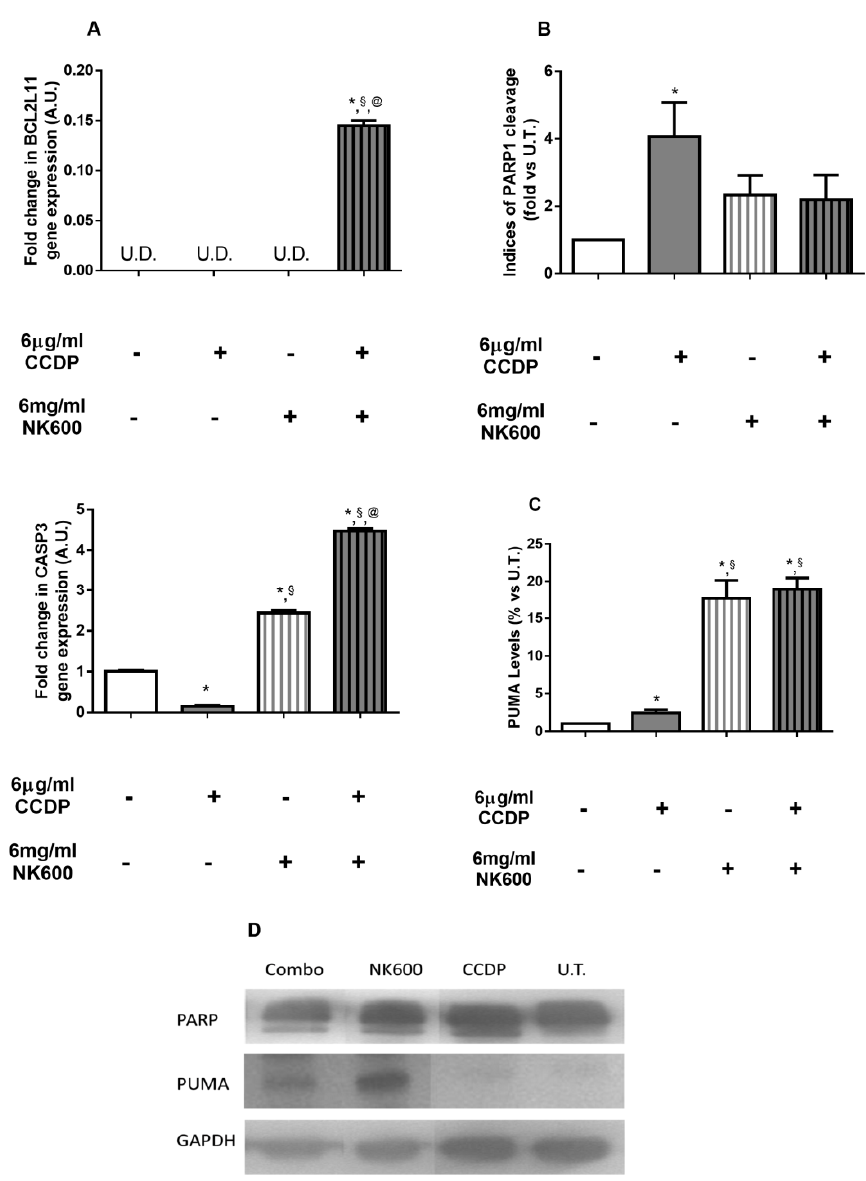
Figure 6. Apoptosis analysis. ( A ) Gene expression analysis was performed on DLD1 after 12 h of 6 μ g/mLof CCDP, 6 mg/mLof NK600, and Combo 6 exposure.BCL2L11 and CASP3. Data are expressed as fold-increases relative to untreated cultures at the same end-point and are normalized to the GAPDH housekeeping gene expression. ( B , C ) Immunoblotting analysis. Bars represent the ratio of cleaved PARP( B ) and Puma protein levels ( C ), and the data are expressed as fold values vs. U.T. DLD1 cells. ( D ) The figures depicted are representative of at least three similar immunoblot analyses of PARP and PUMA protein levels in untreated DLD1, and in treated DLD1 (6 μ g/mL of CCDP, 6 mg/mLof NK600, and Combo 6). GAPDH was used as an internal control for equal protein loading on gel. The data represent the mean ± standard deviation (SD) of 3 independent experiments. *